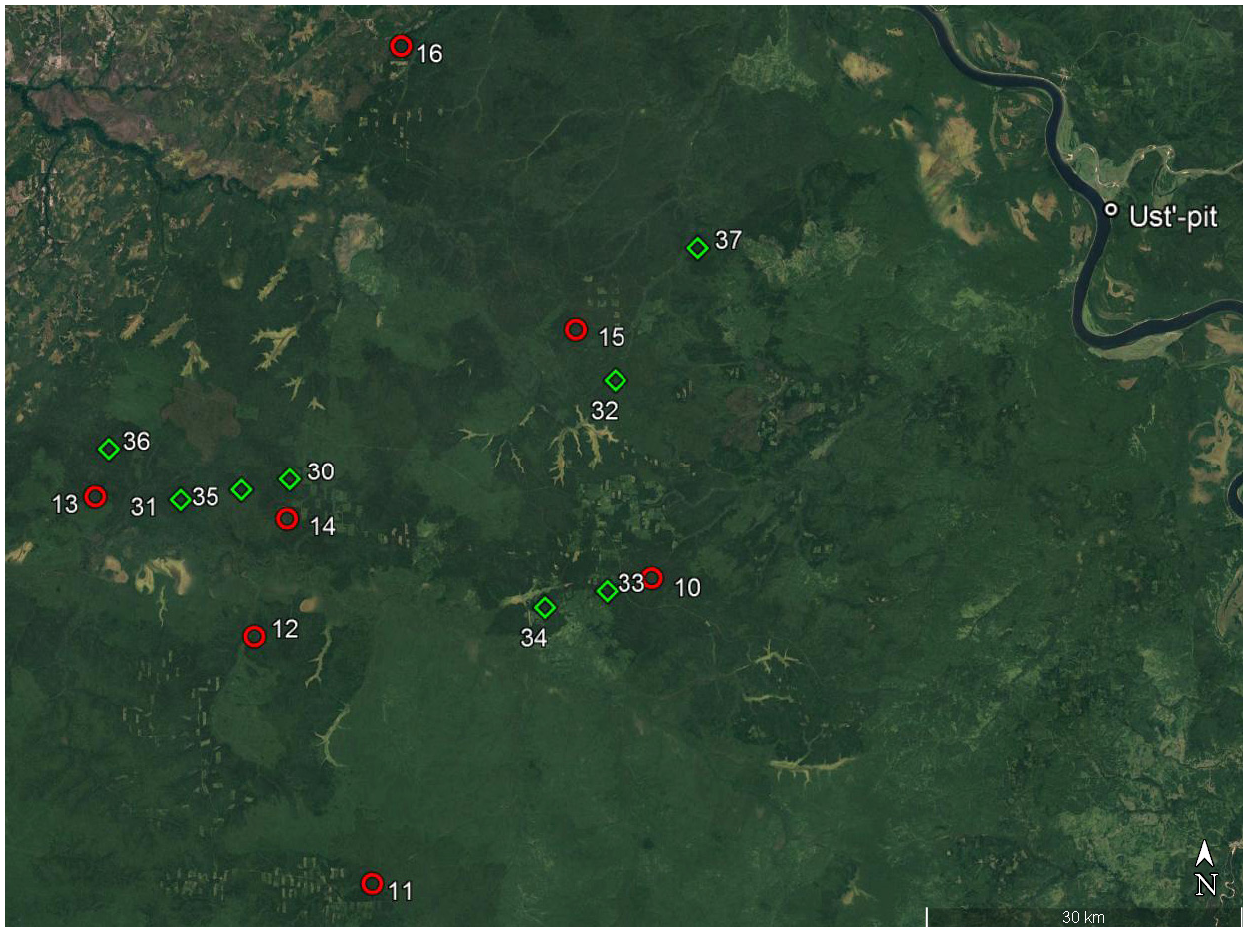
Figure 3. Sample plots near the outbreak of Siberian silk moth (Yenisei River Basin near Ust’-Pit village, Russia). Red dots—stands damaged by the pest; green dots—undamaged stands.